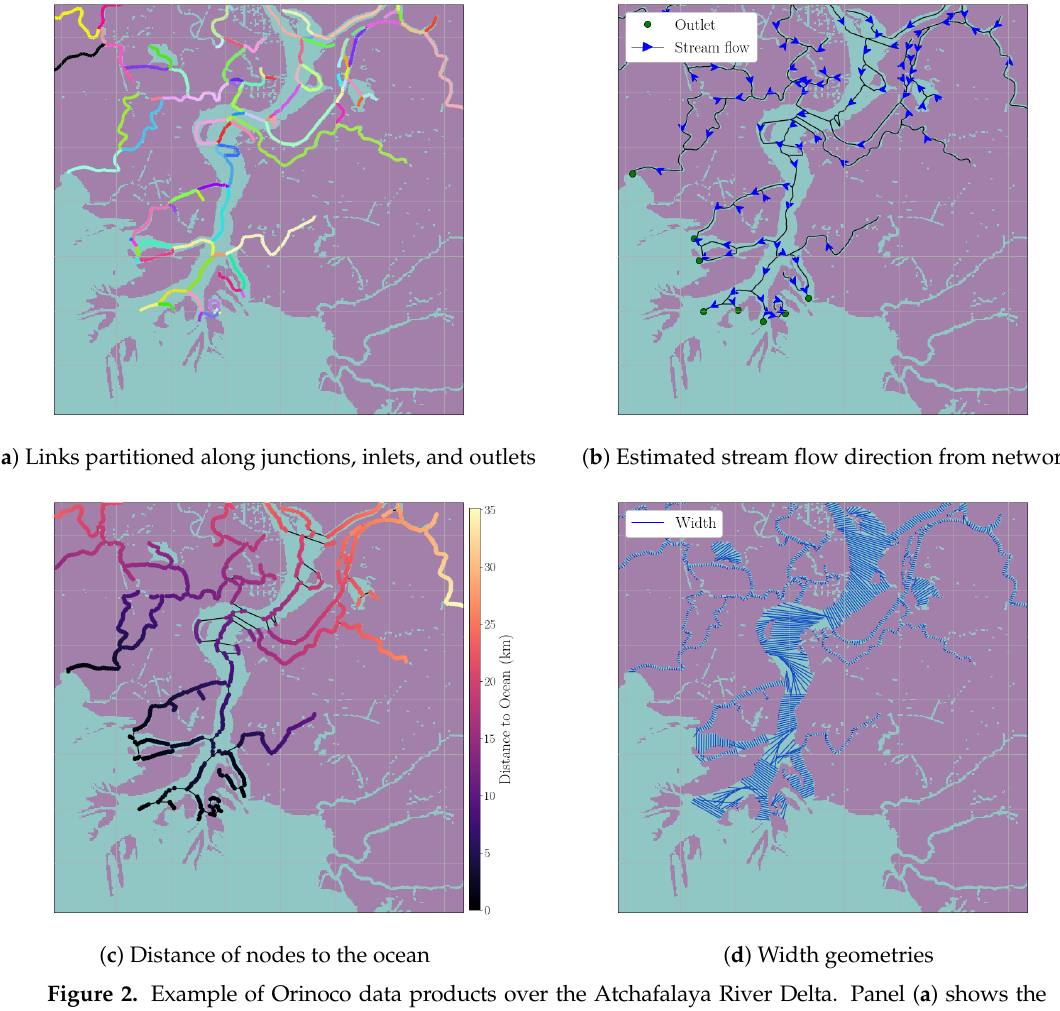
Figure 2. Example of Orinoco data products over the Atchafalaya River Delta. Panel ( a ) shows the partition of the links into contiguous paths as specified in the text. Using this partition and ϕ , panel ( b ) shows the estimated stream flow direction. Each node’s distance to the ocean within the channel network is shown in panel ( c ) and the width and their associated orientation in the channels, in panel ( d ).